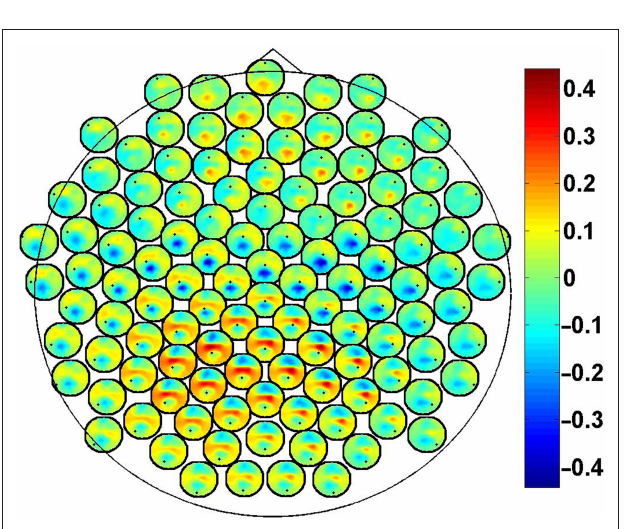
FIGurE 3 | Imaginary part of coherency at 10 Hz. Each small circle corresponds to one row of the coherency matrix.